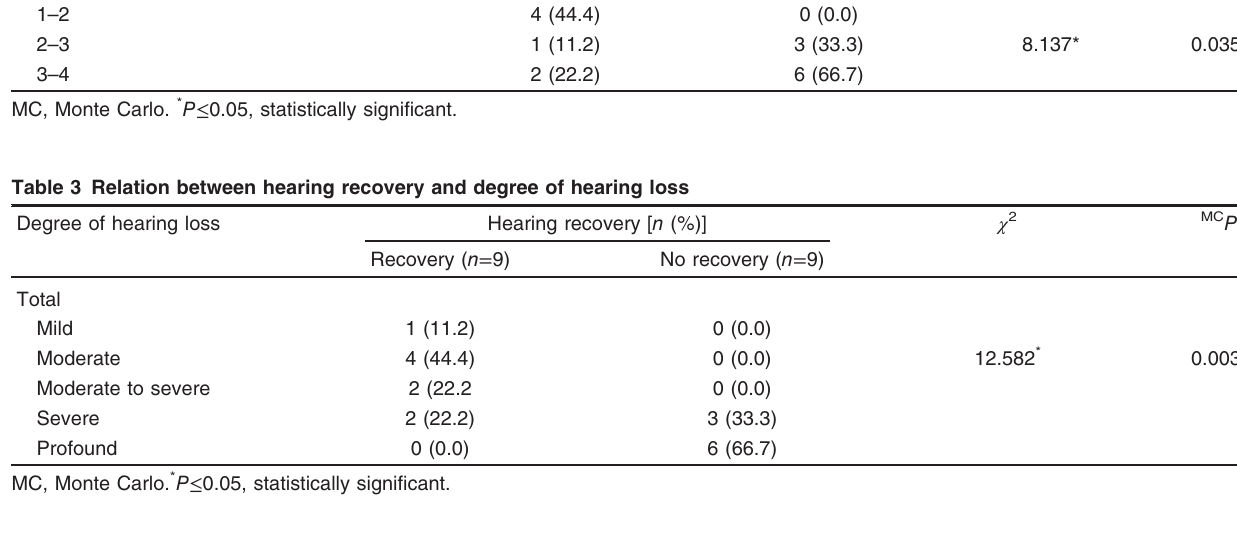
Table 4 Relation between hearing recovery and shape of the audiogram ( N = 18) Shape of audiogram